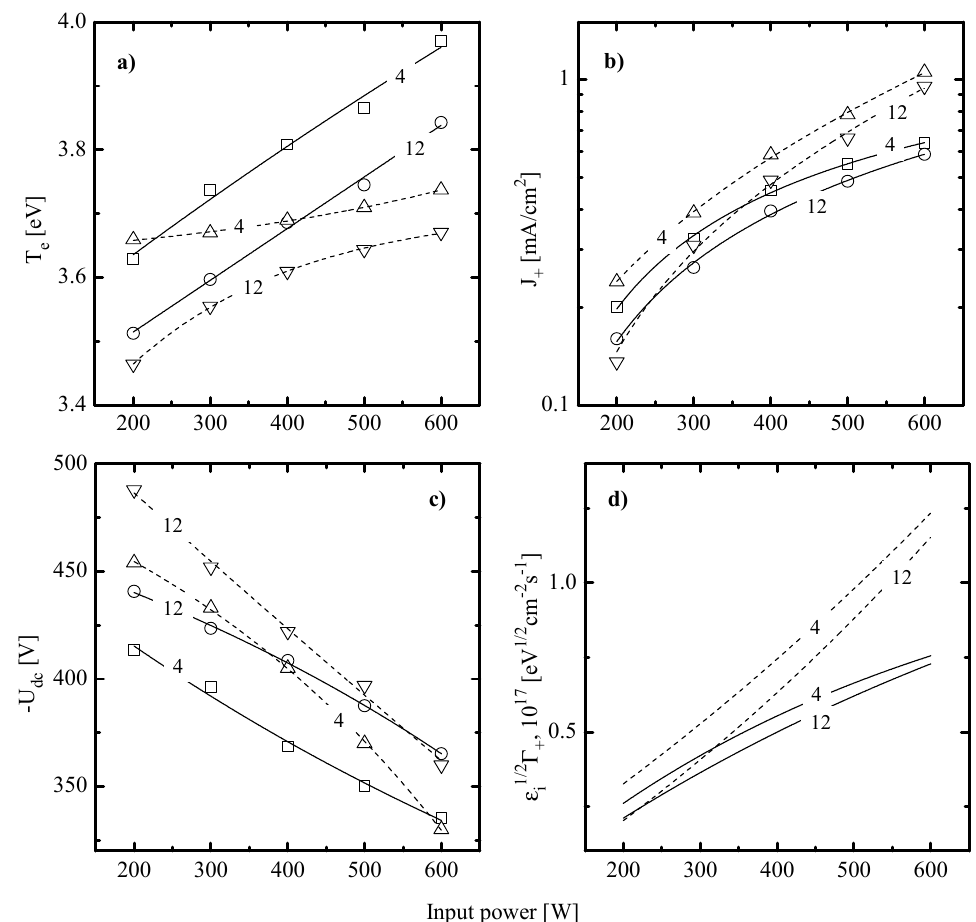
Figure 4. Electron- and ion-related plasma parameters in 50% C 6 F 12 O + 50% Ar (solid lines) and 50% CF 4 + 50% Ar (dashed lines) plasmas: ( a ) electron temperature; ( b ) ion current density; ( c ) negative dc bias at constant W dc = 200 W; and ( d ) parameter Γ characterizing the ion momentum flux. Numerical labels on curves mean the gas pressure in mTorr.